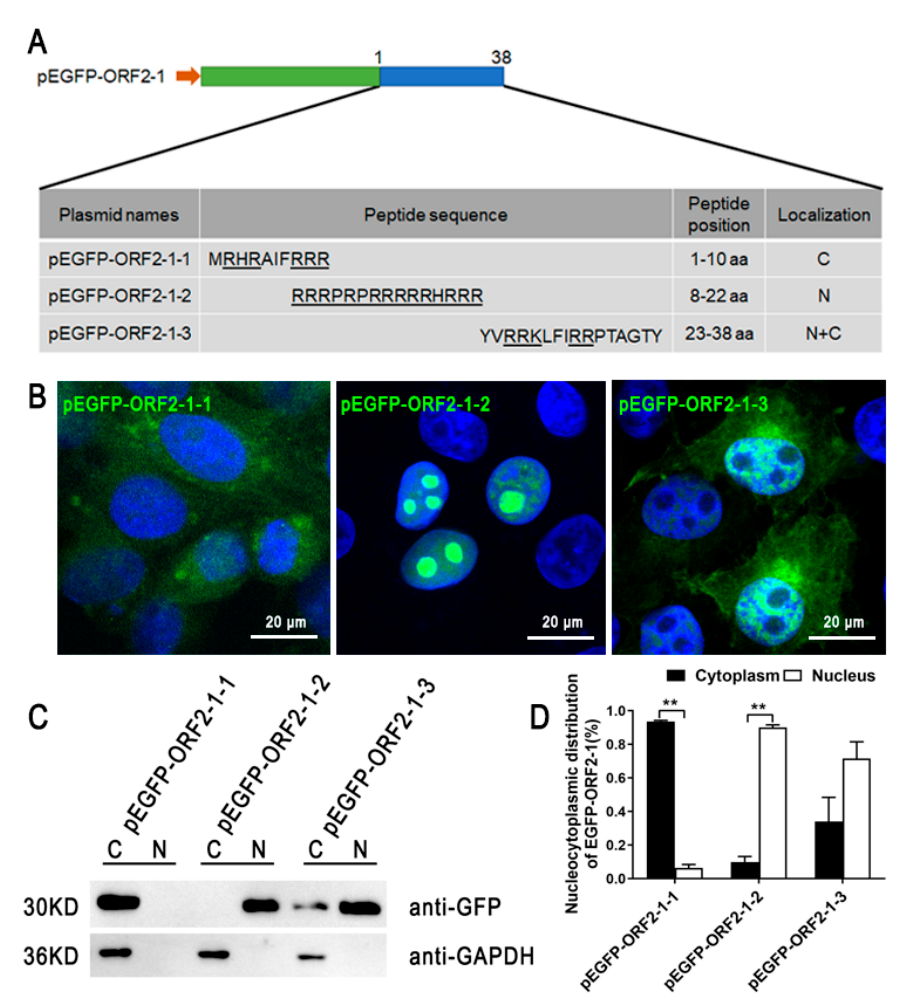
Figure 2. The NLS motifs in ORF2-1. ( A ) pEGFP-ORF2-1-1 (1–10 aa), pEGFP-ORF2-1-2 (8–22 aa), pEGFP-ORF2-1-3 (23–38 aa) were constructed and predicted NLSs were listed. ( B ) PK-15 cells were transfected with recombinant plasmids and observed by confocal microscopy after 24 h. Scale bars = 20 μ m. ( C ) and ( D ) The nucleus and cytoplasm were extracted from the transfected PK-15 cells, and the abundance of expressed proteins in the extracts were detected by western blot after nuclear and cytoplasmic extraction, nuclear/cytoplasmic distribution of the expressed proteins was analyzed through densitometric quantification using Image-Pro software, data from three independent experiments are shown on the graph as the average ± standard error. One-way ANOVA; ** p < 0.01.